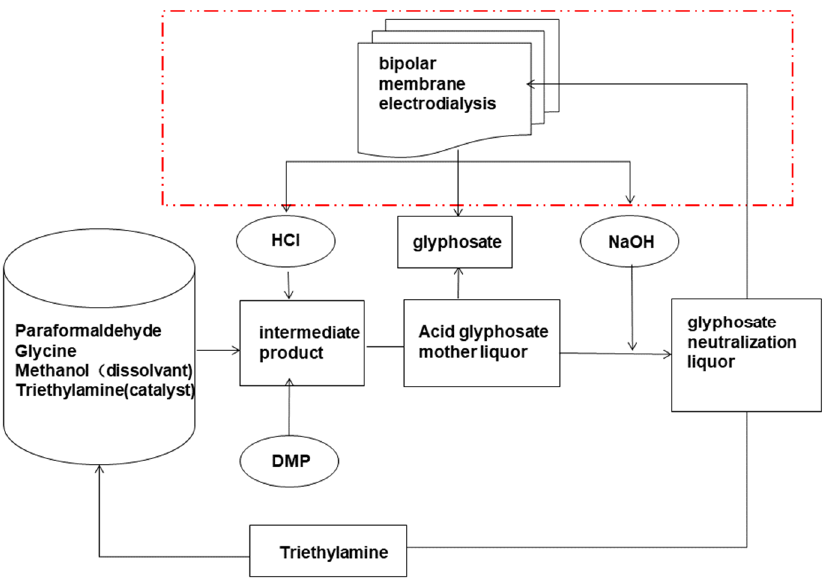
Figure 6. A simple technological flow diagram of the glycine–dimethylphosphit process coupled with a BMED process [43].